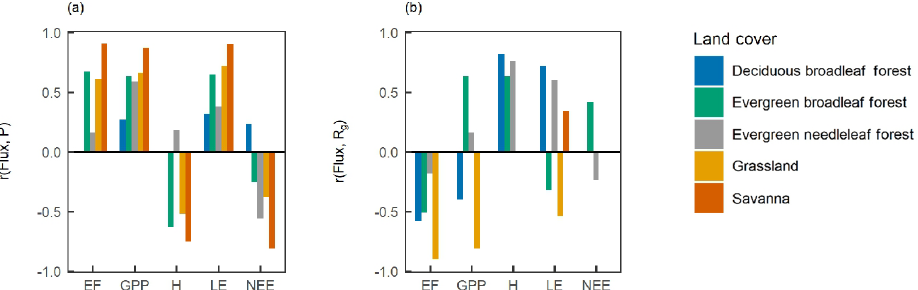
Figure 8. Water and energy control on surface fluxes. The correlation coefficient ( r ) of site-year surface fluxes versus (a) the mean yearly precipitation ( P ) and (b) incoming shortwave radiation (Rg). Each bar indicates a significant correlation at p < 0 .